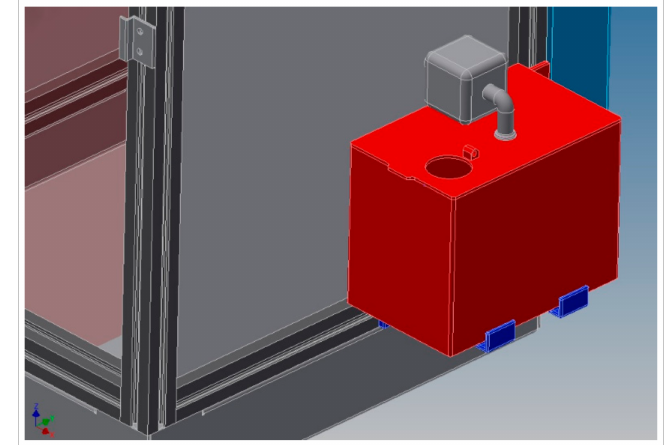
Figure 10. Humidifying unit 3-D CAD